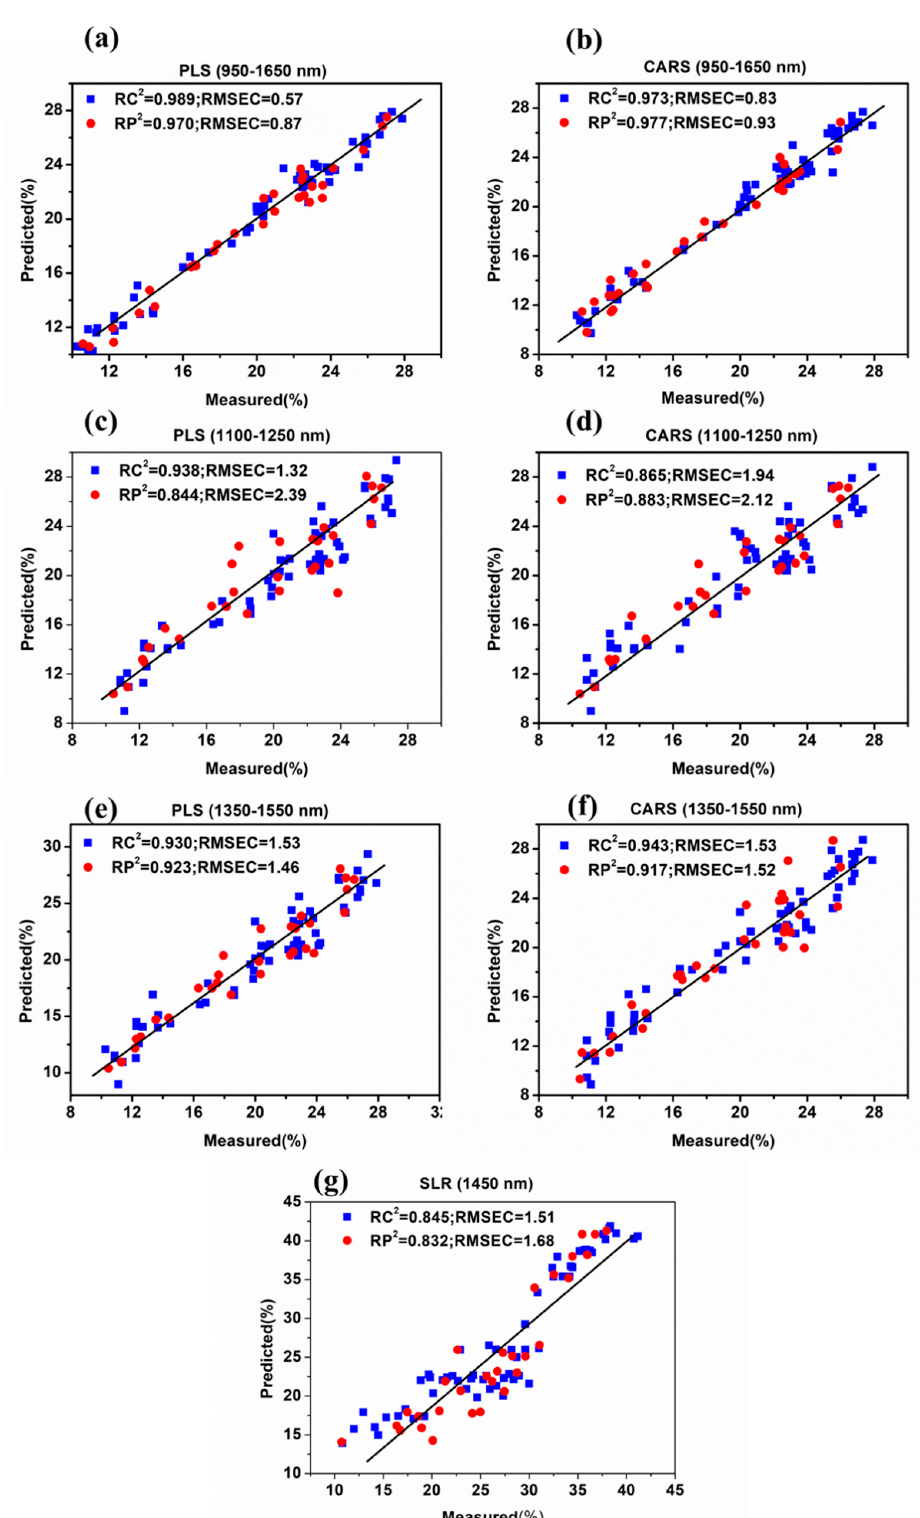
Figure 2. The model performance of 950–1650 nm modeled by Partial Least Squares (PLS) ( a ) and Competitive Adaptive Reweighted Squares (CARS) ( b ); The model performance of 1100–1250 nm Near-infrared spectroscopy (NIR) modeled by PLS ( c ) and CARS ( d ); The model performance of 1350-1550 nm NIR spectra modeled by PLS ( e ) and CARS ( f ). The model performance of 1450 nm NIR spectra modeled by SLR ( g ).